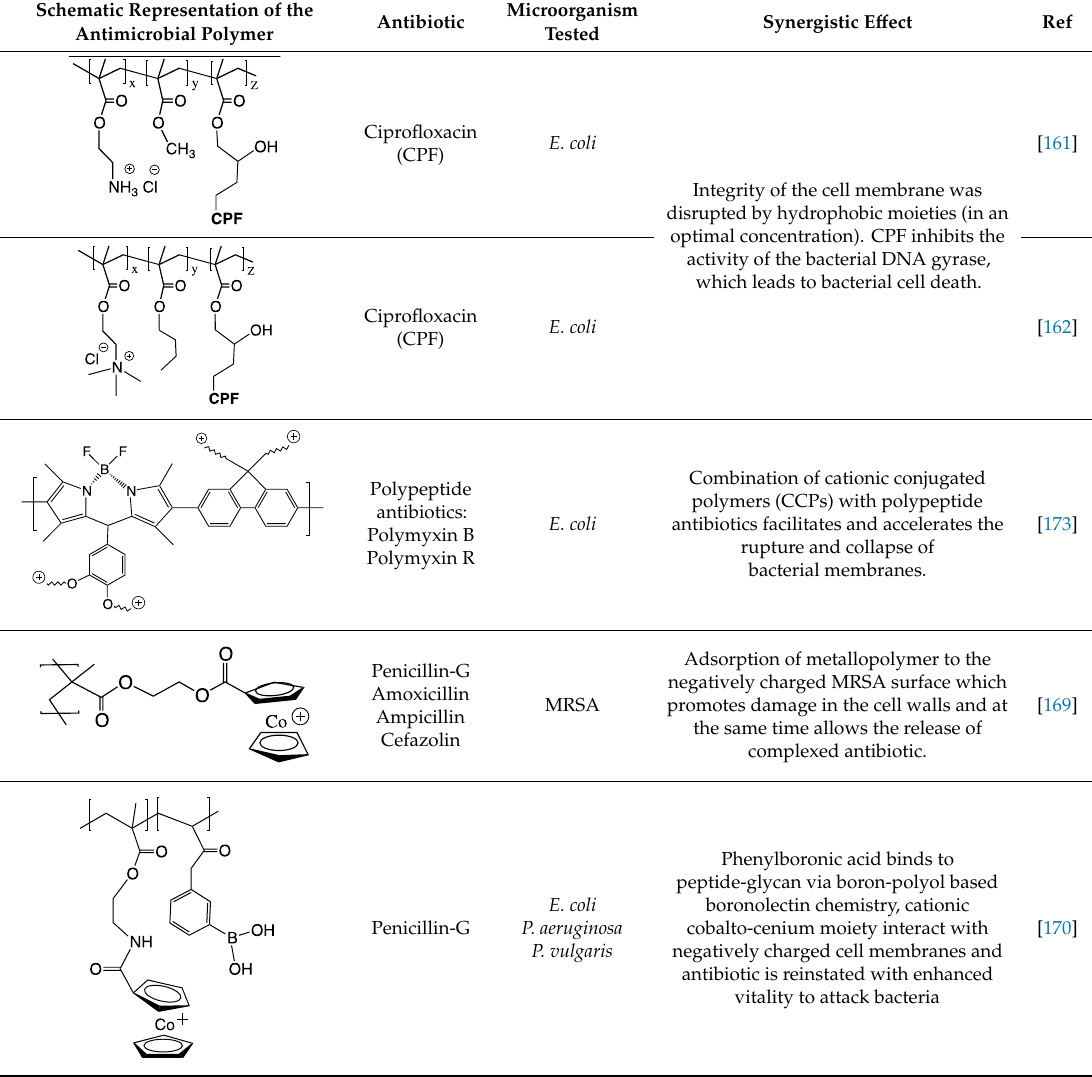
Table 4. Selected antimicrobial systems based in cationic polymers and antibiotics. Schematic Representation of the